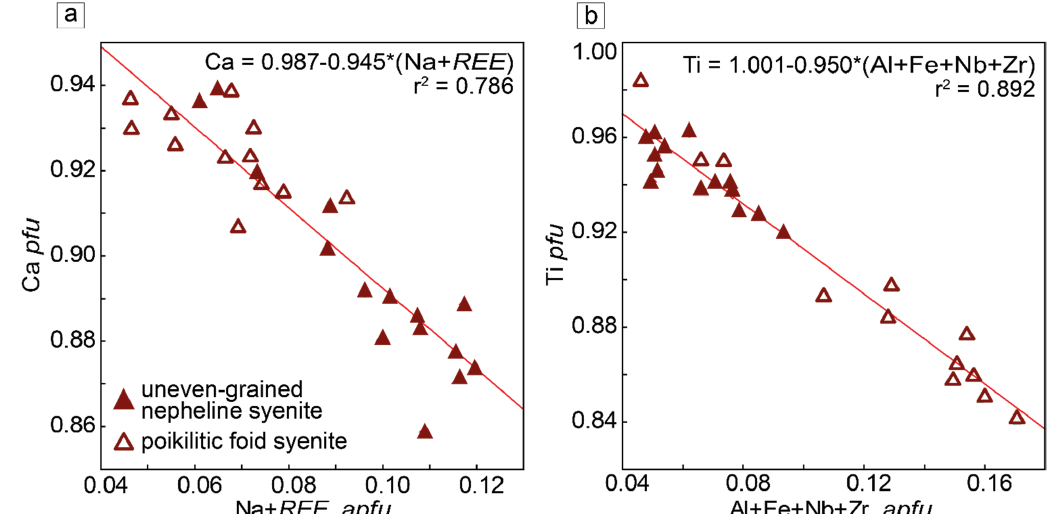
Figure 14. Important substitutions in titanite from poikilitic rocks: ( a ) substitution in the Ca-site according to the scheme 2Ca 2+ ⇆ Na + + REE 3+ ; ( b ) binary diagram shows that Ti is involved in a number of substitutions according to the schemes 2Ti 4+ ⇆ Nb 5+ + (Al, Fe 3+ ) and Ti 4+ ⇆ Zr 4+ .